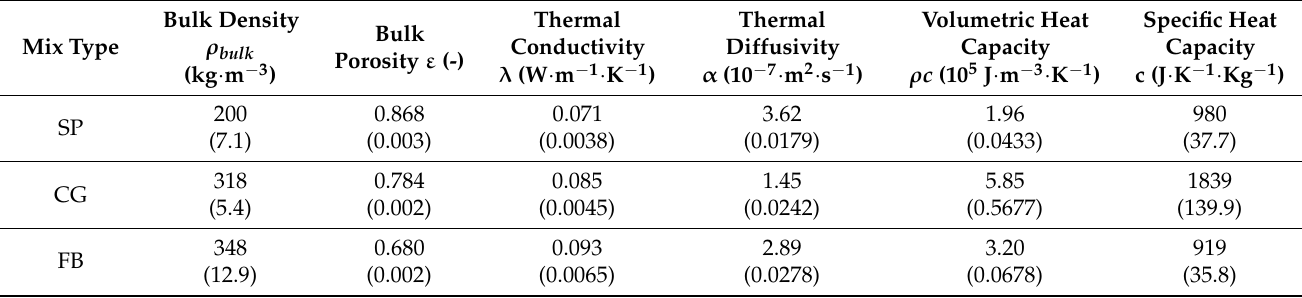
Table 3. Physical and thermal properties (The values in the brackets are the standard